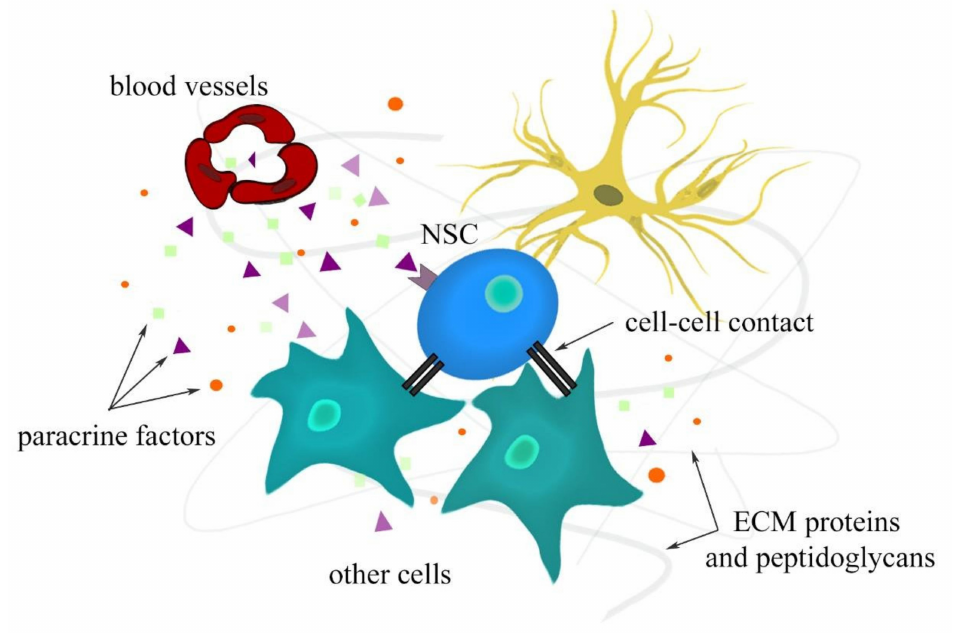
Figure 2. Interactions in neural stem cell